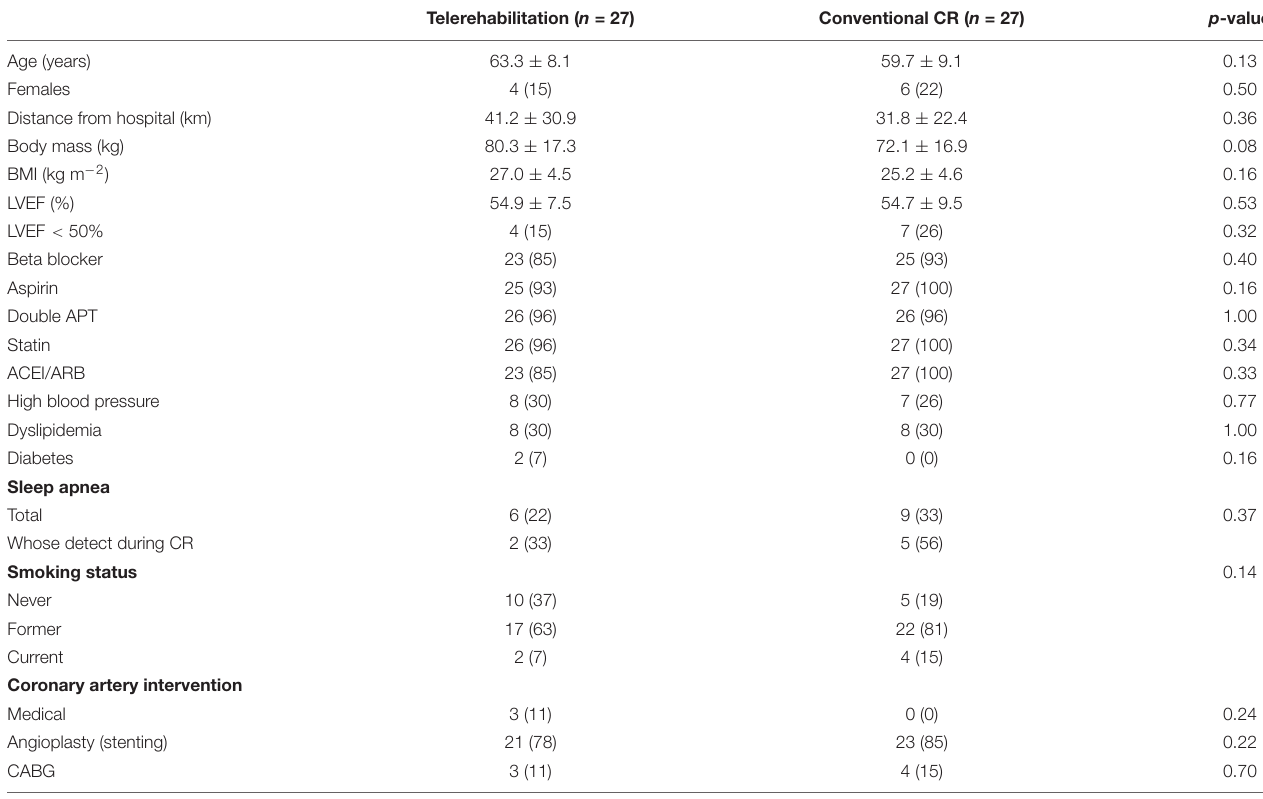
TABLE 1 | Baseline characteristics of the participants.